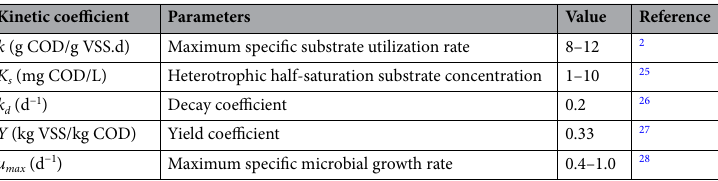
Table 3. Monad kinetic coefficient in ASP.